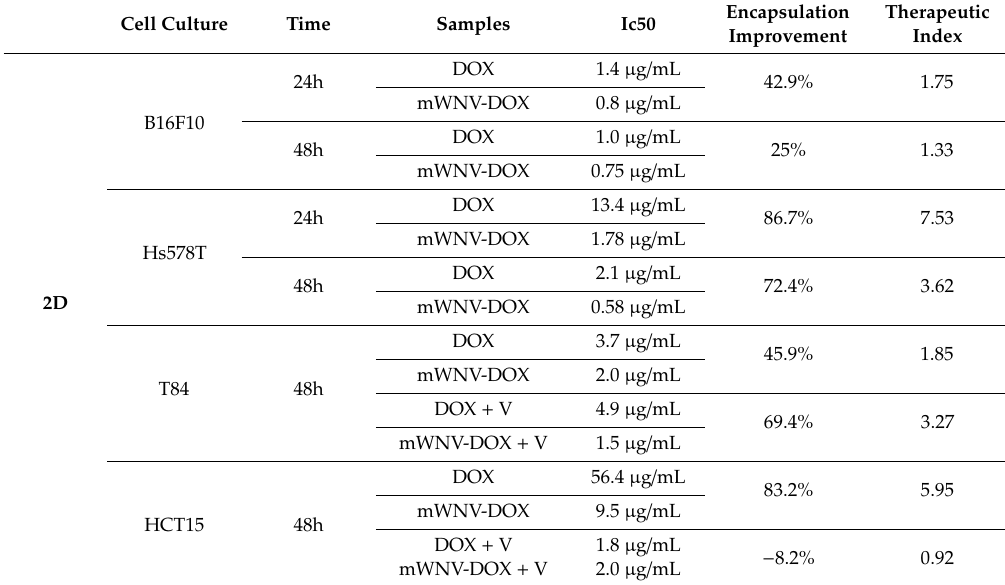
Table 1. Summary of the IC 50 , therapeutic indexes and encapsulation improvement (normalised mWNVs-DOX IC50 values with respect to the IC50 of free DOX, and expressed in %) obtained from 2D tests on the di ff erent cell lines considered for this